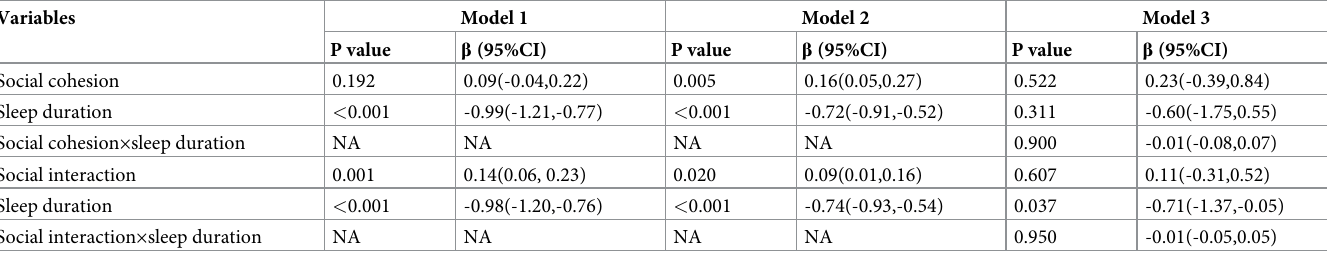
Table 3. Linear regression model for interaction between SC and sleep duration on cognitive decline (n = 955).